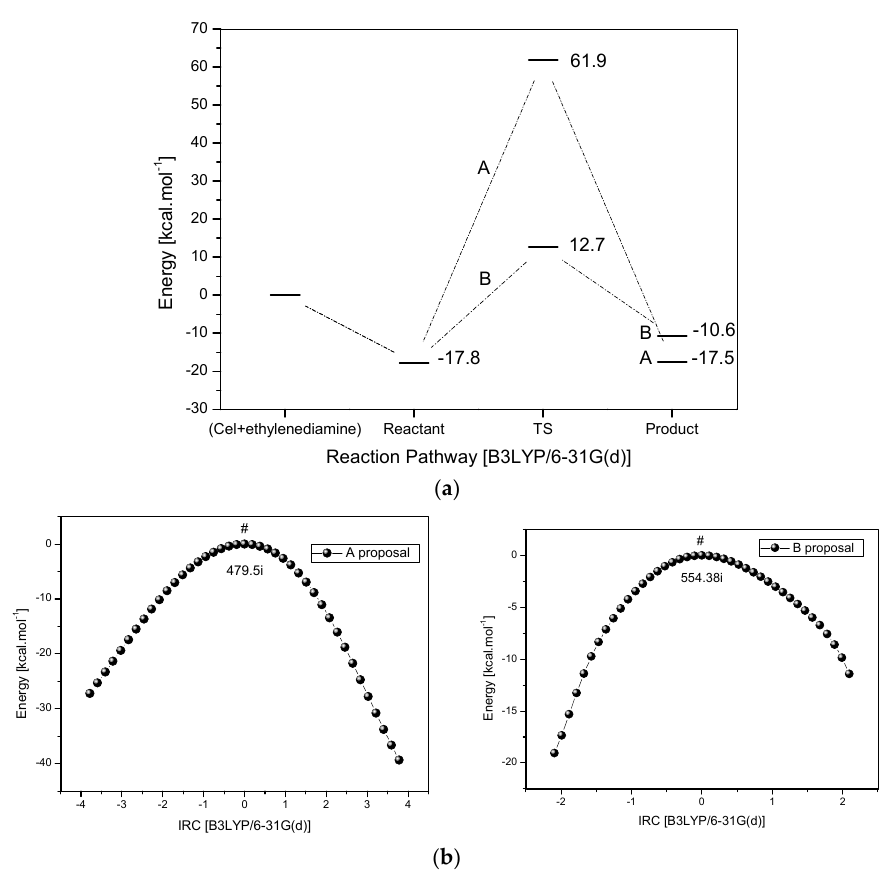
Figure 6. ( a ) Energy profile for the reaction between cellulose and ethylenediamine; ( b ) IRC for the reaction between cellulose and ethylenediamine, route A (left) and route B (right).